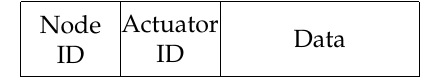
Figure 10. Interaction with the actuator subframe